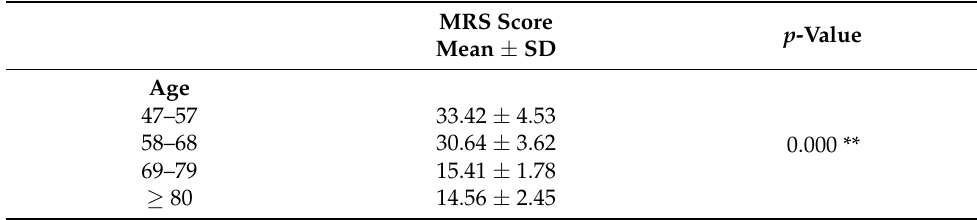
Figure 2. Severity of postmenopausal symptoms according to MRS among Saudi women attending different primary health centers. Table 3. Sociodemographic and menopausal correlates of MRS score among Saudi women attending different primary health